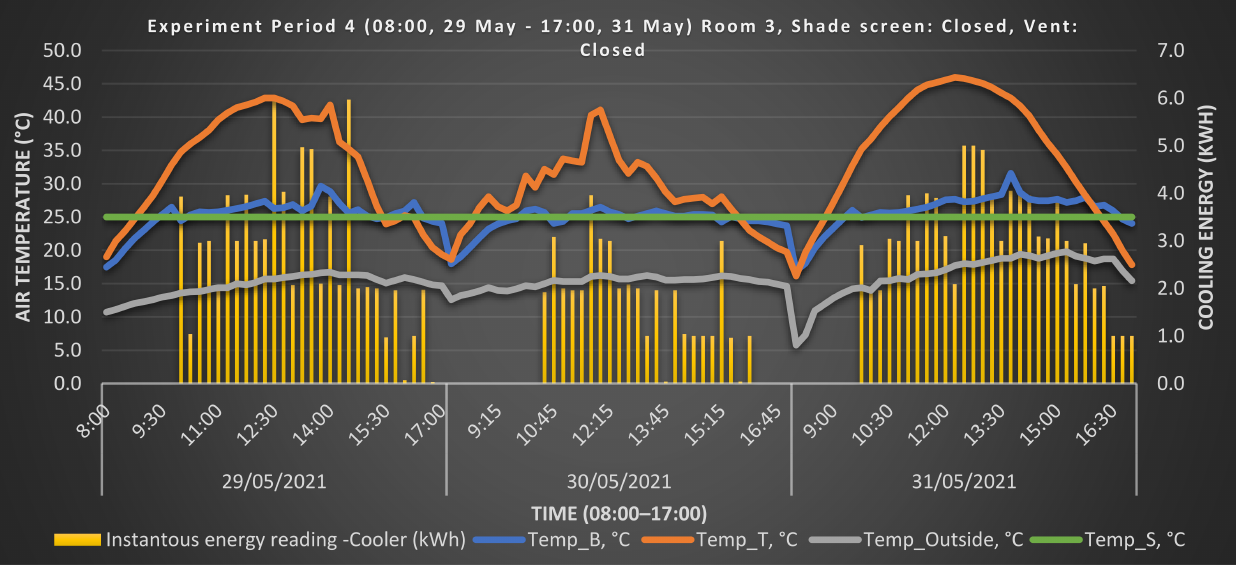
Figure 5. Temperature and energy use in different vent and shade screen status in experimental Period 4. Air temperatures ( ◦ C) collected at the base (B), top (T), and outside are depicted in blue, orange, and white lines, respectively. Energy use (kWh) measured by mechanical coolers is depicted over time using yellow bars along with air